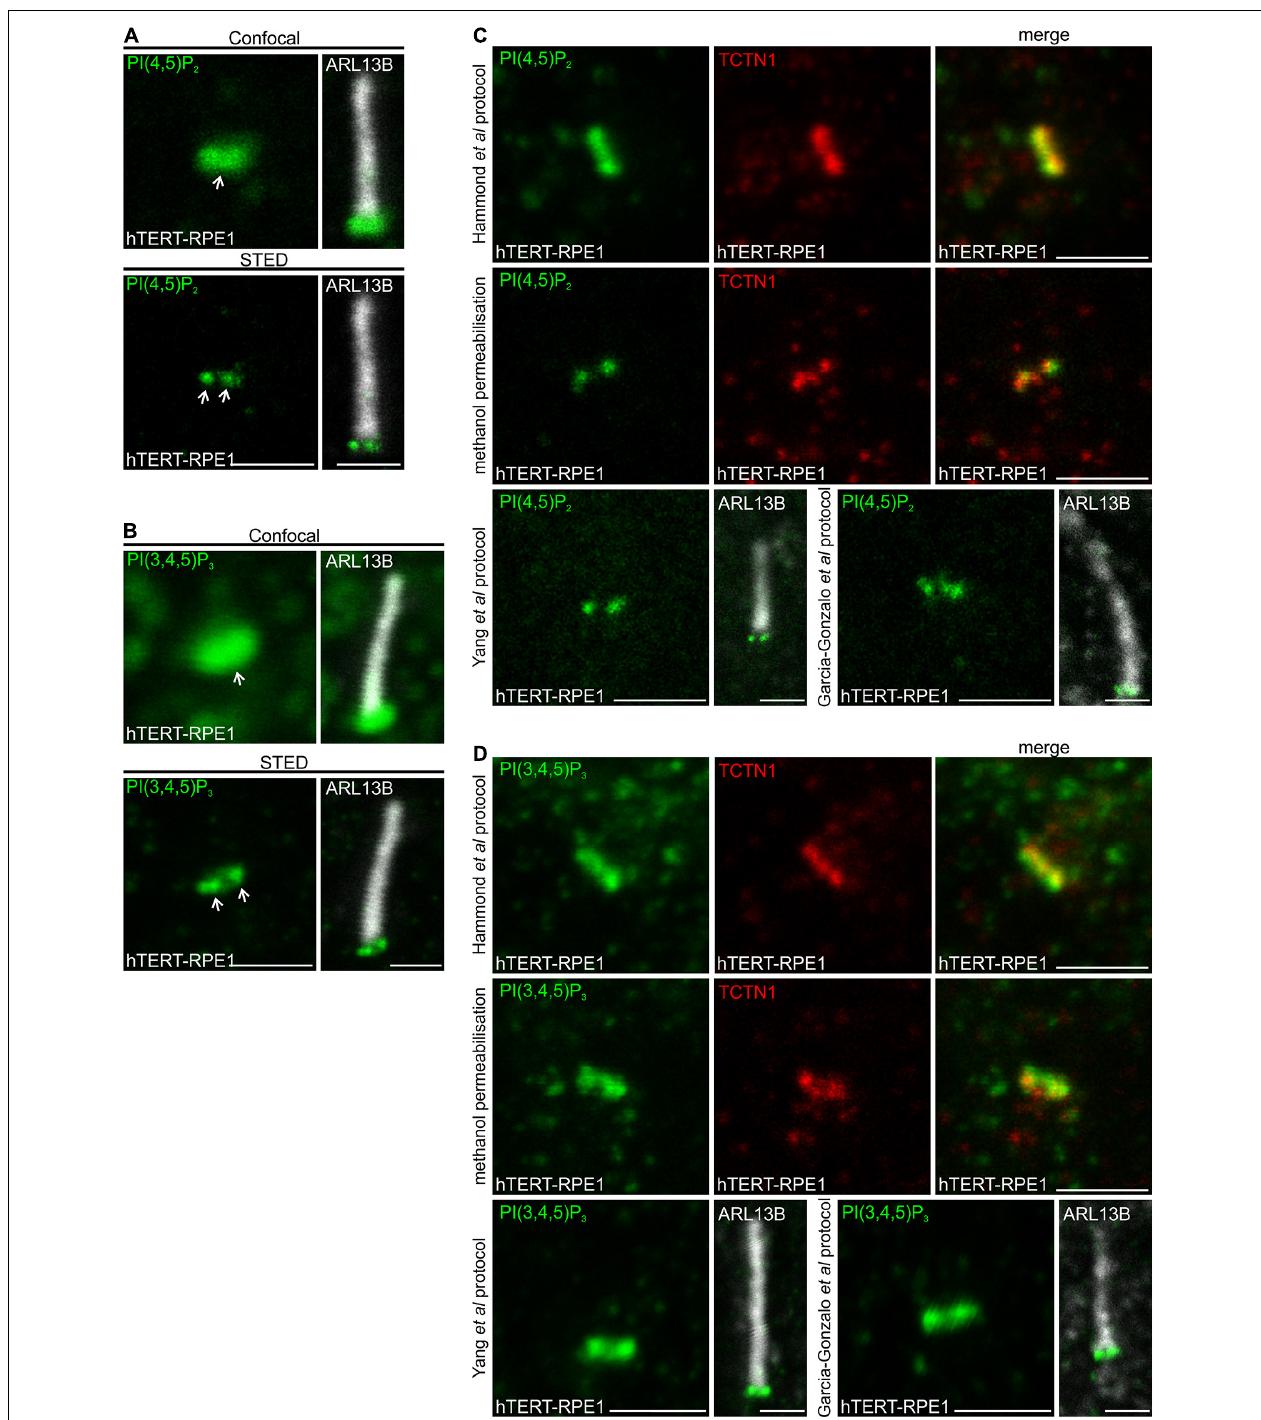
FIGURE 1 | PI(4,5)P 2 and PI(3,4,5)P 3 localize to the transition zone in ciliated hTERT-RPE1 cells. (A,B) Ciliated hTERT-RPE1 cells were immunostained with (A) PI(4,5)P 2 or (B) PI(3,4,5)P 3 (green) and ARL13B (grayscale) antibodies and imaged by confocal and STED microscopy. Right panels show merged image at lower magnification. Arrows indicate transition zone PI(4,5)P 2 signals, bar indicates 1 µ m. (C,D) Ciliated hTERT-RPE1 cells were immunostained with (C) PI(4,5)P 2 (green) or (D) PI(3,4,5)P 3 (green) and TCTN1 (red) or ARL13B (grayscale) antibodies using the Hammond et al. (2009) Golgi protocol, the methanol permeabilization protocol, the Yang et al. (2015) or Garcia-Gonzalo et al. (2011) protocol and imaged by confocal microscopy, bar indicates 1 µ m.